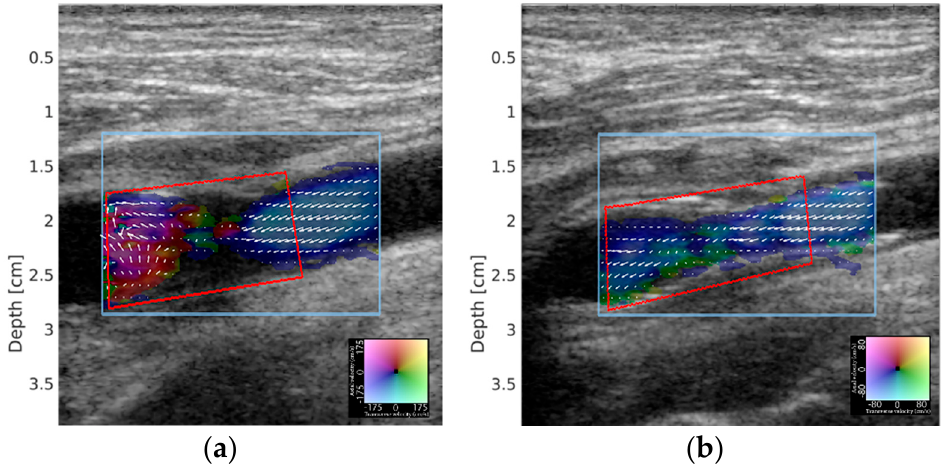
Figure 1. Vector flow imaging (VFI) example of a carotid artery stenosis patient (no. 10) before and after carotid artery stenting (CAS) treatment. In ( a ), complex flow is observed within the stenosis, while flow is almost laminar after stent treatment in ( b ). Vector concentration (VC) of flow in the stenosis was 0.45 before and 0.85 after stent treatment. VC was calculated within the ROI delineated by the red